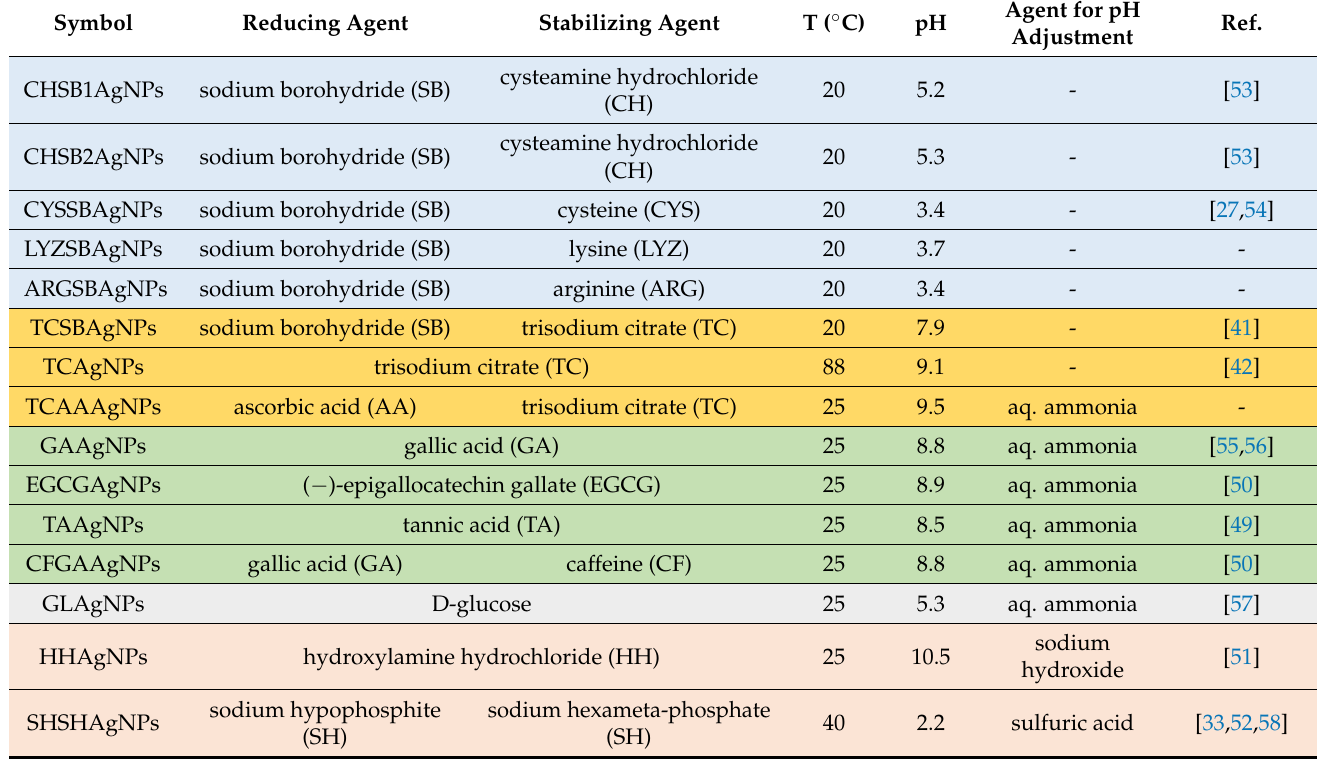
Agent for pH Adjustment